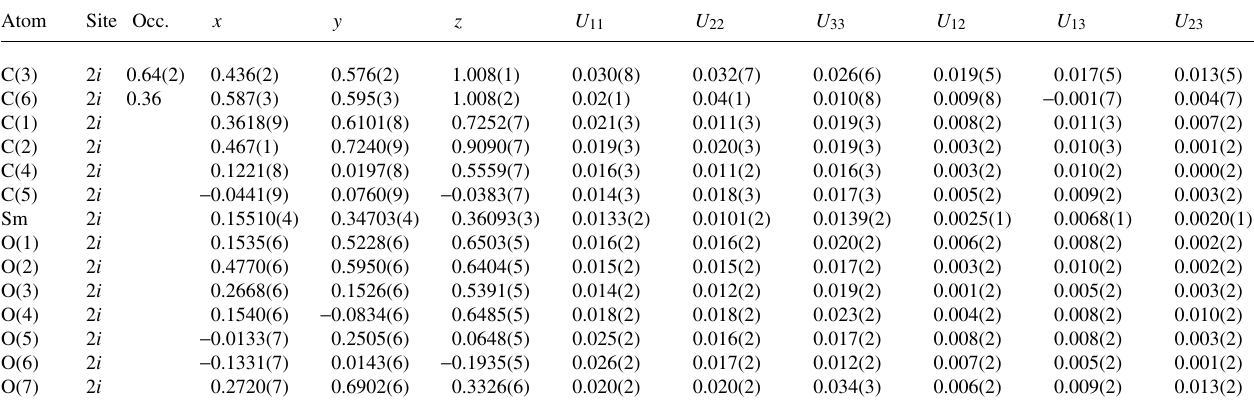
Table 3. Atomic coordinates and displacement parameters (in Å 2 ) .